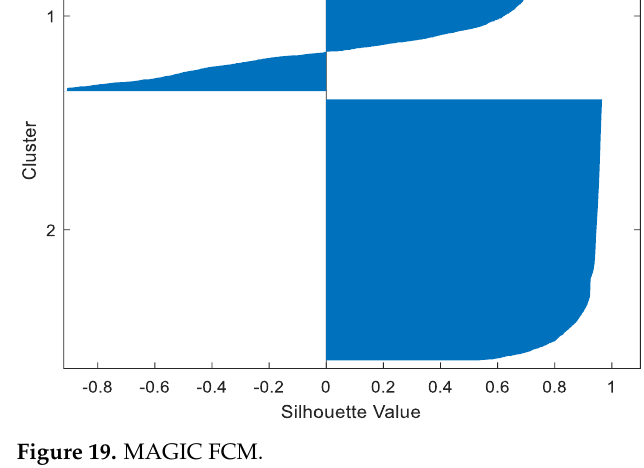
Figure 19. MAGIC FCM.